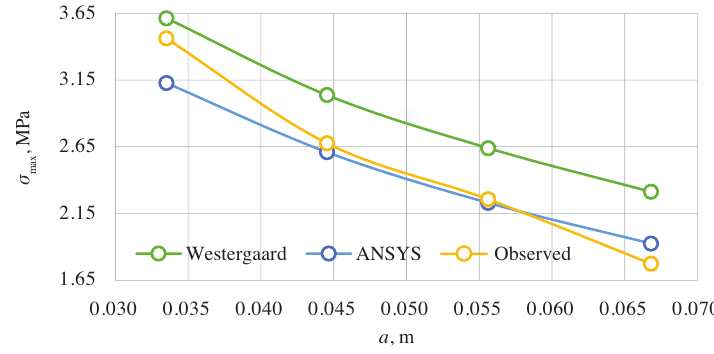
Figure 8. Variation of load area radius ( h = 2.54 cm and load at the